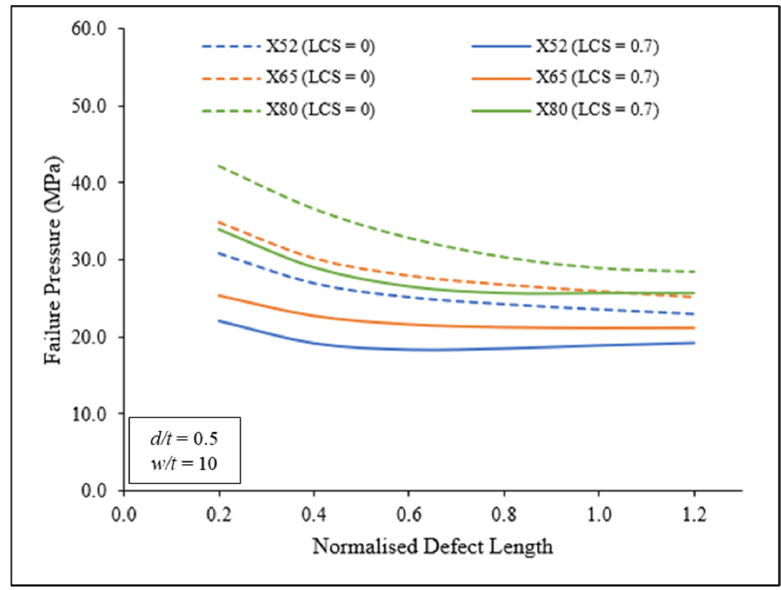
Figure 13. Failure pressure against normalised defect length with 0.2 and 0.8 normalised defect depths for X52, X65, and X80.